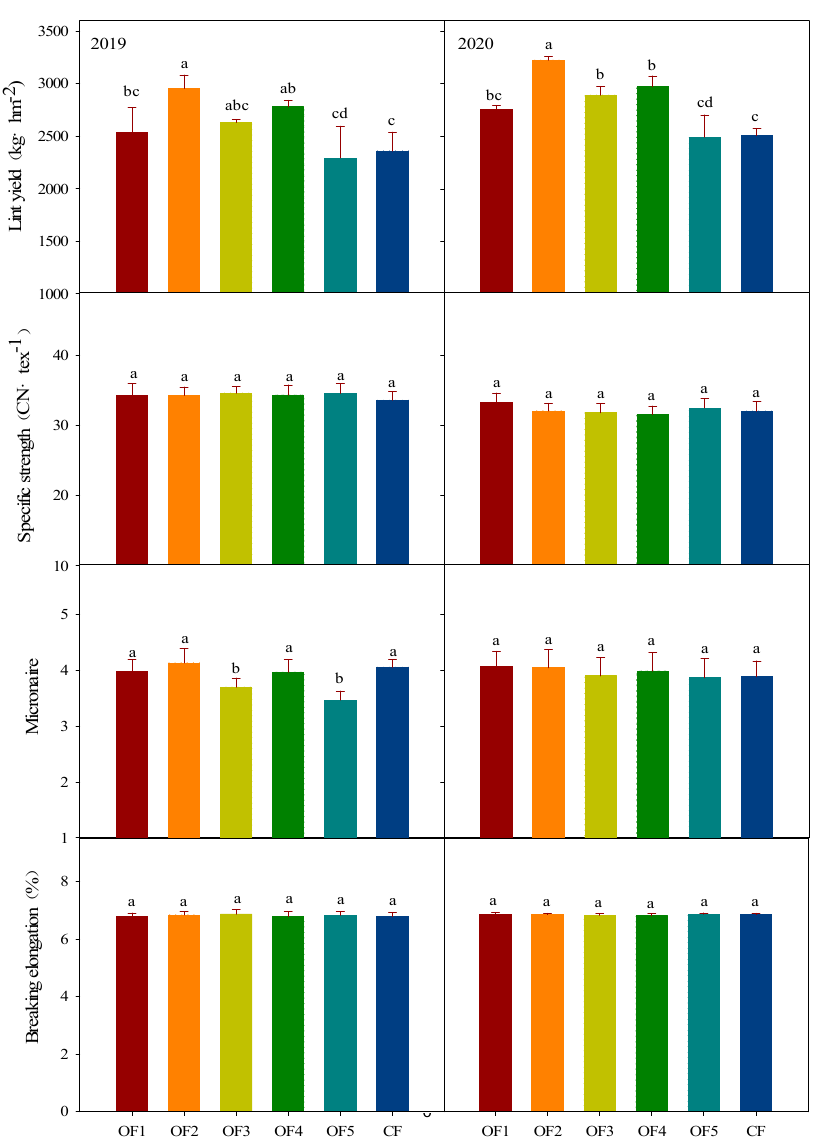
Figure 8. Effect of organic liquid fertilizer combined with different ratios of chemical fertilizers on cotton yield and quality. Different letters above the columns indicate statistical significance at the p = 0.05 level between different treatments in each